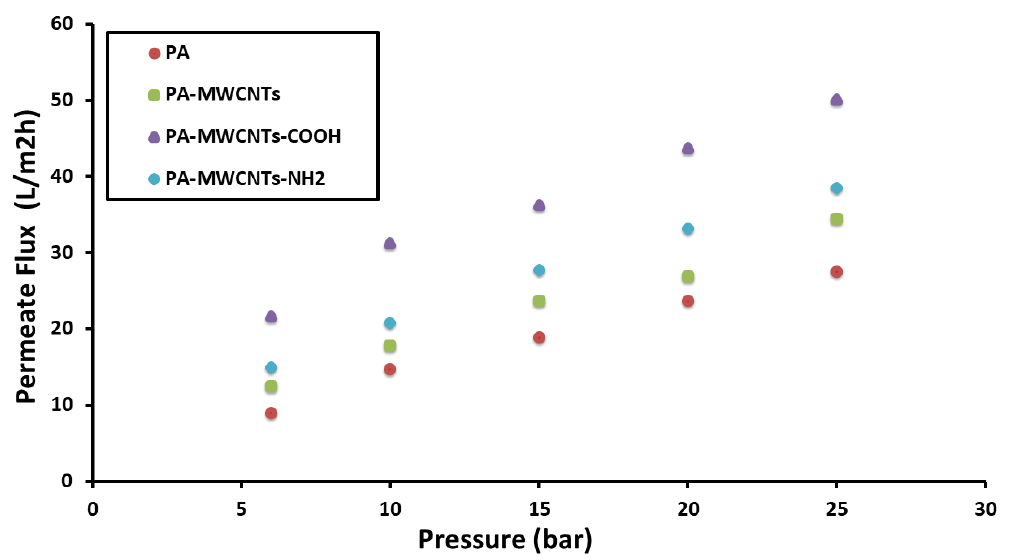
Figure 12. Flux rates plotted against transmembrane pressure of PA and PA-MWCNTs, PA-MWCNTs-COOH, and PA-MWCNTs-NH 2 .